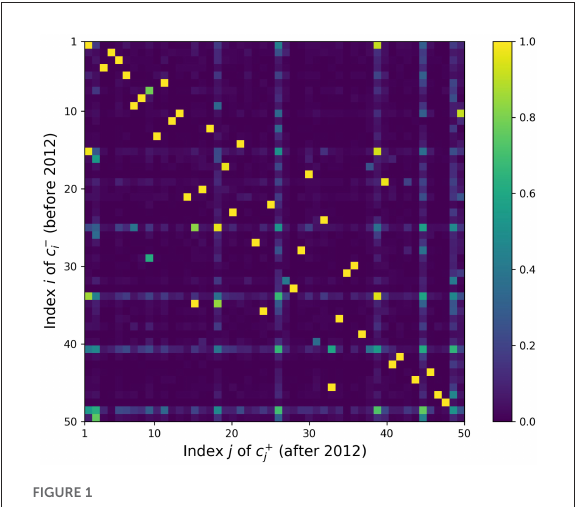
FIGURE1 Topic similarity matrix S . The element S ij in the i th row and j th column represents the similarity between the i th before topic and j th after topic in terms of paper distributions.